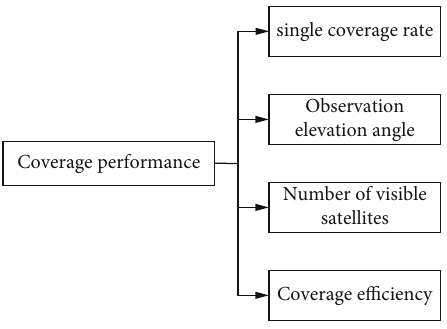
Figure 1: Coverage performance